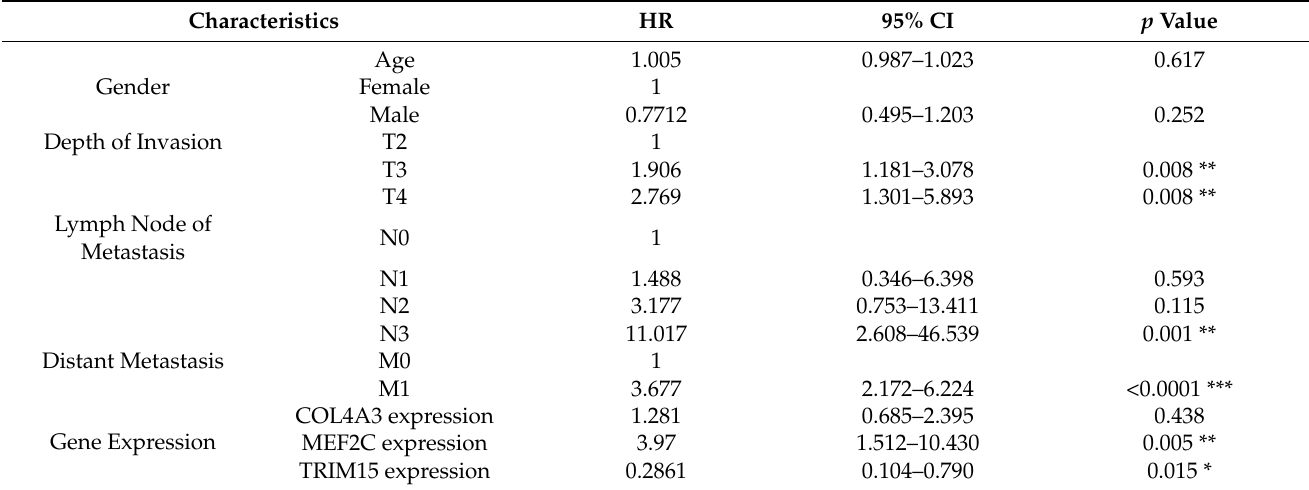
Table 3. The univariate Cox regression analysis between three genes and other clinical characteristics and OS in diffuse-type gastric cancer.